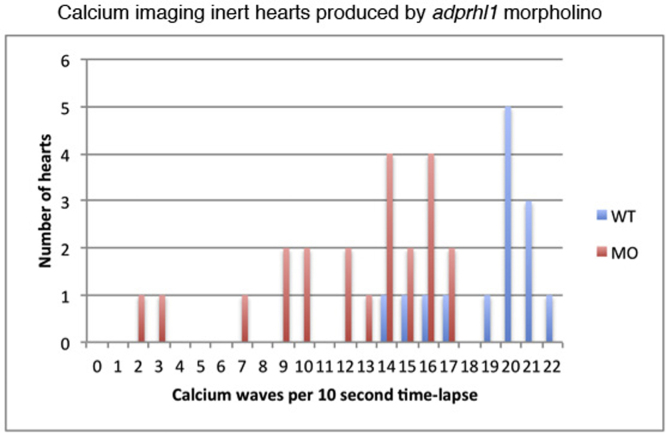
Calcium imaging inert hearts produced by adprhl1 morpholino. Chart showing the number of calcium waves recorded during 10 s movie clips in 22 different Adprhl1-e2i2MO injected, inert tadpole hearts compared with 14 wildtype controls at stage 42. The frequency of Ca2+ transients is reduced with the morpholino, but is not the primary cause of the cardiac functional defect. A lower 20 ng mass of morpholino was used in this experiment to accommodate co-injection of the RNA into embryos. Thus a reduced proportion of tadpoles developed the complete phenotype associated with the Adprhl1-e2i2MO (20 out of 42 tadpoles injected, 48%).